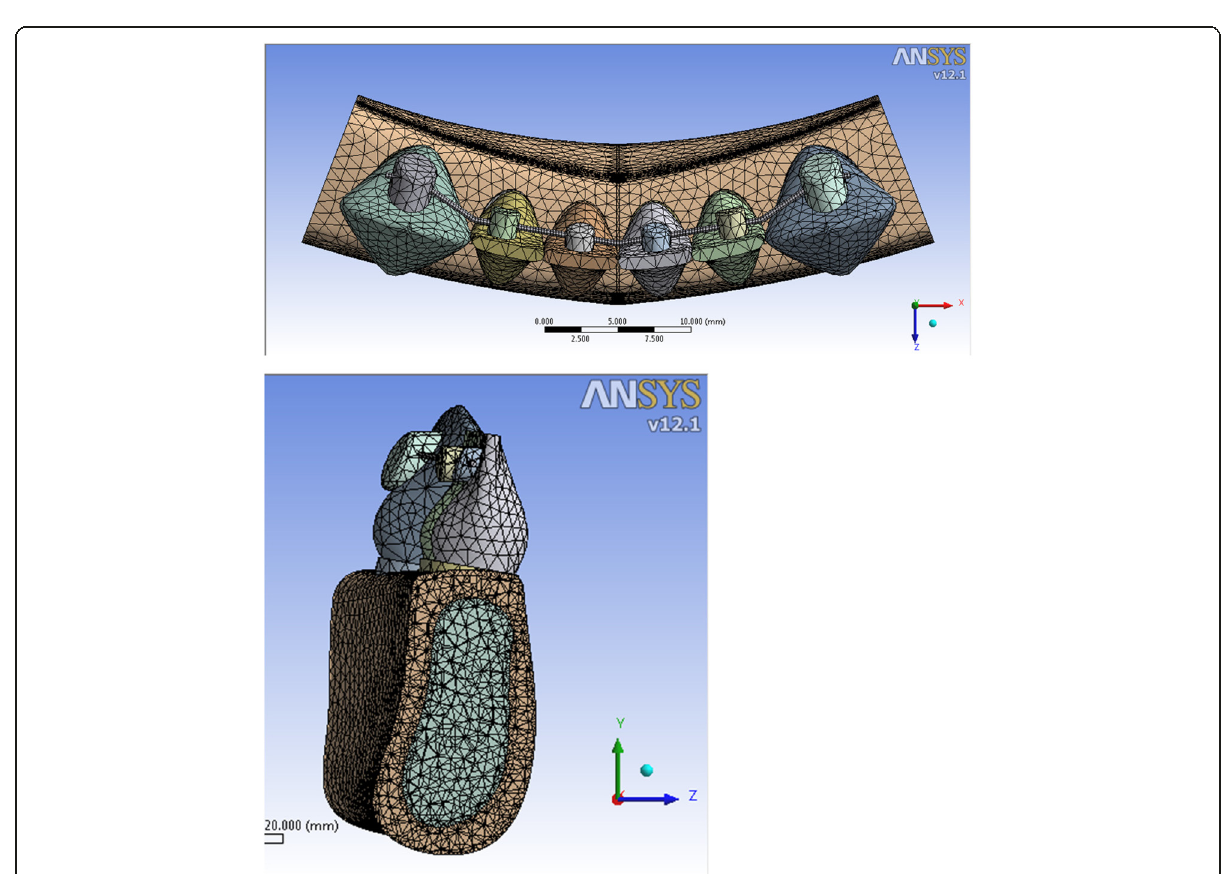
Fig. 3 Meshed model 3 showing the inclination of the anterior teeth at 100° to the horizontal plane